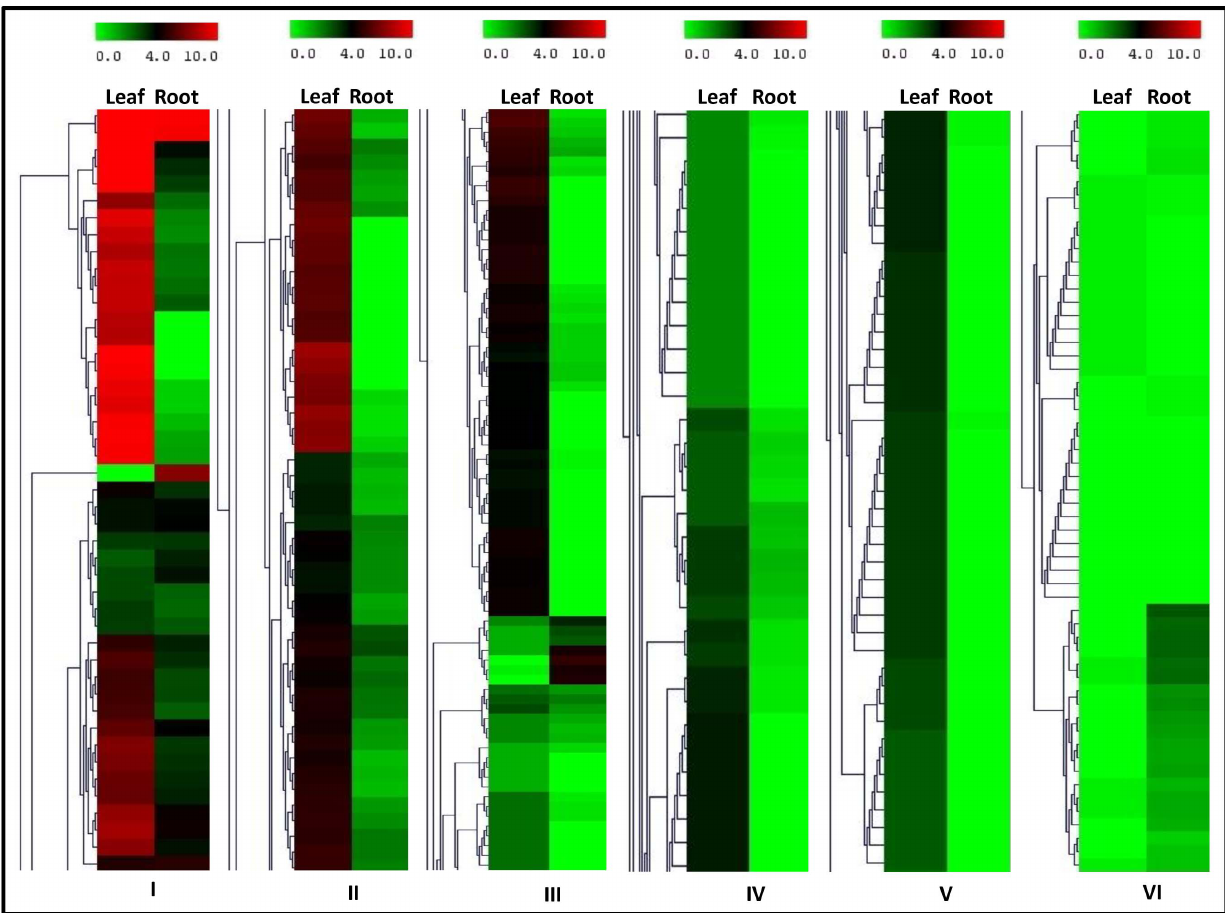
Figure 6. Clusters containing cytochrome P450 with their differential expression in leaf and root. Two columns represent leaf and root, while each row represents contigs encoding different members of CYP450 gene family (Table S12). Clustering was carried out with log 2 tpm value of each contig in leaf and root transcriptome to visualize differential expression.